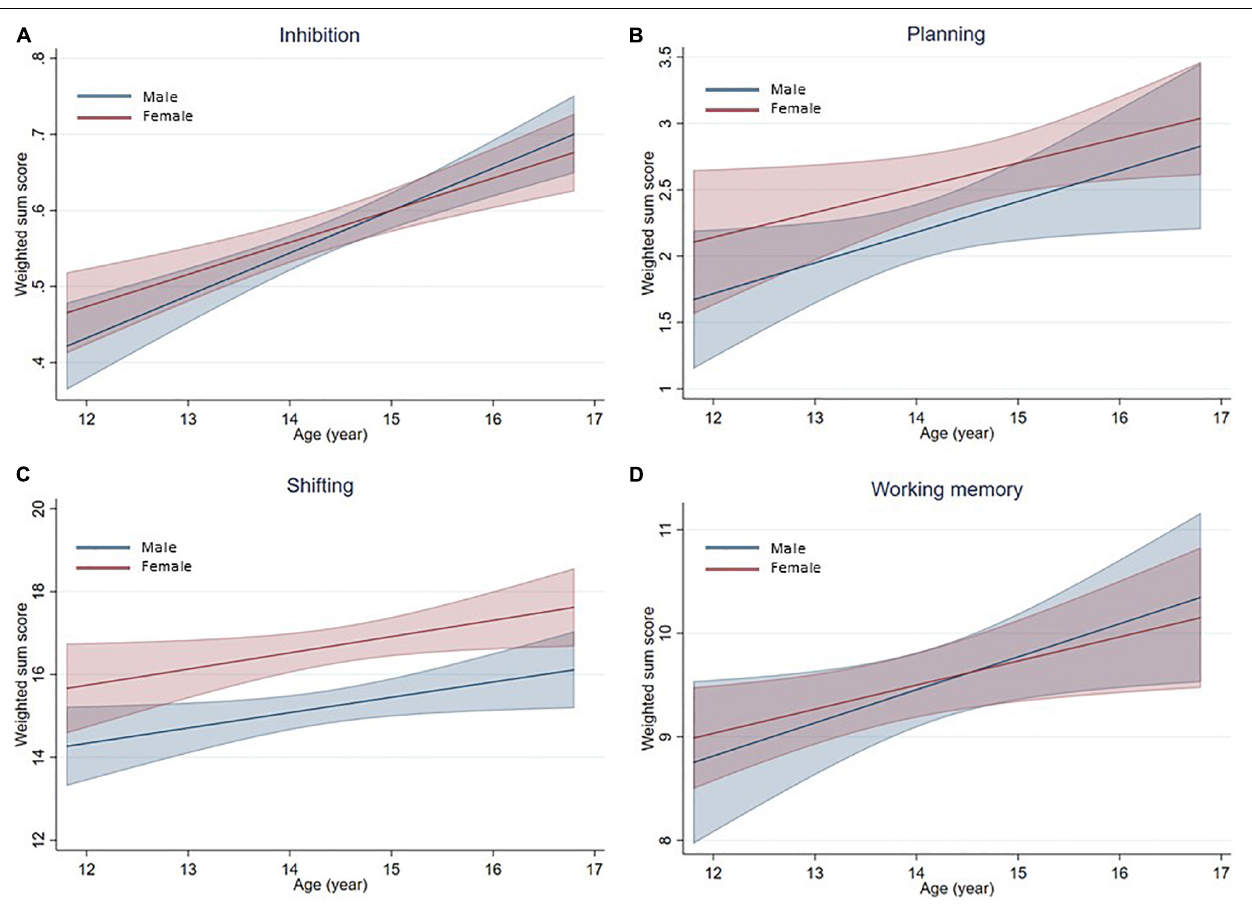
FIGURE 1 | Prediction plots of the means and standard deviations based on GEE Model 1. Per EF component, a prediction of the mean with its standard deviation in relation to age is made, based upon the weighted sum scores. Blue represents males, red females. (A) Inhibition. (B) Planning. (C) Shifting. (D) Working